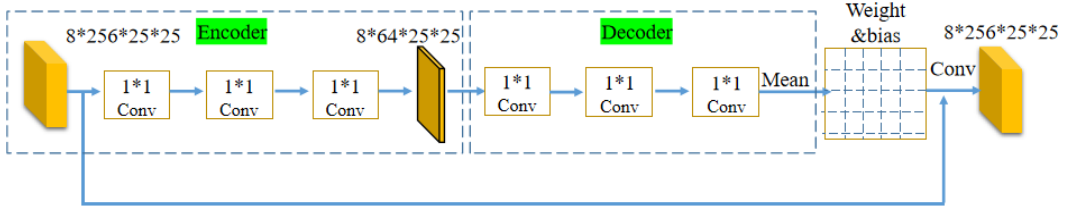
Figure 4. Response map Enhancement. The module consists of Encoder and Decoder. 8*256*25*25 in the figure represent batch*channel*height*width of the characteristic graph, respectively.